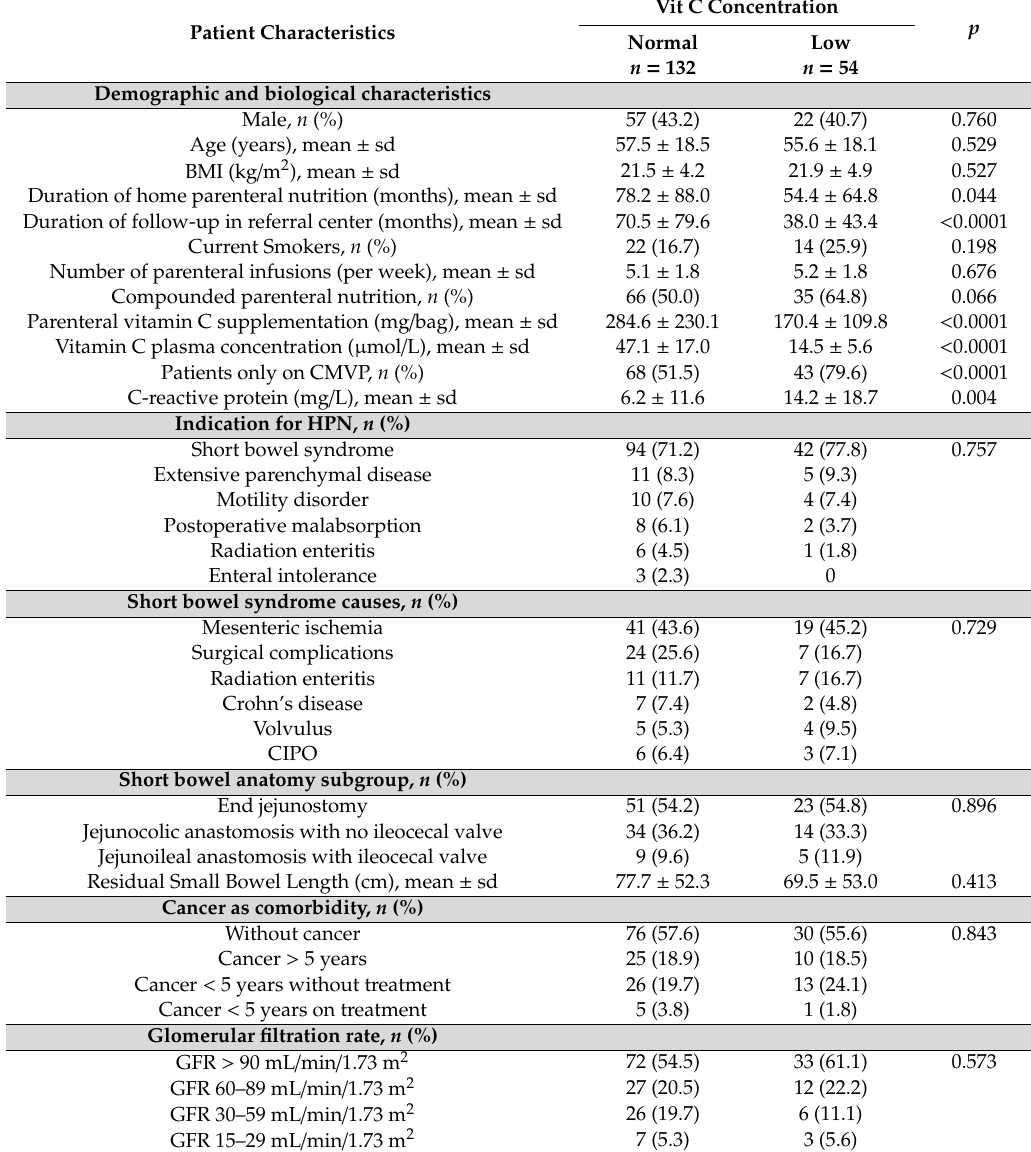
Table 2. Patient characteristics according to their plasma vitamin C